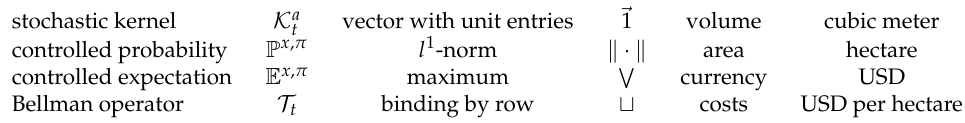
Table 1. Notations and measurement